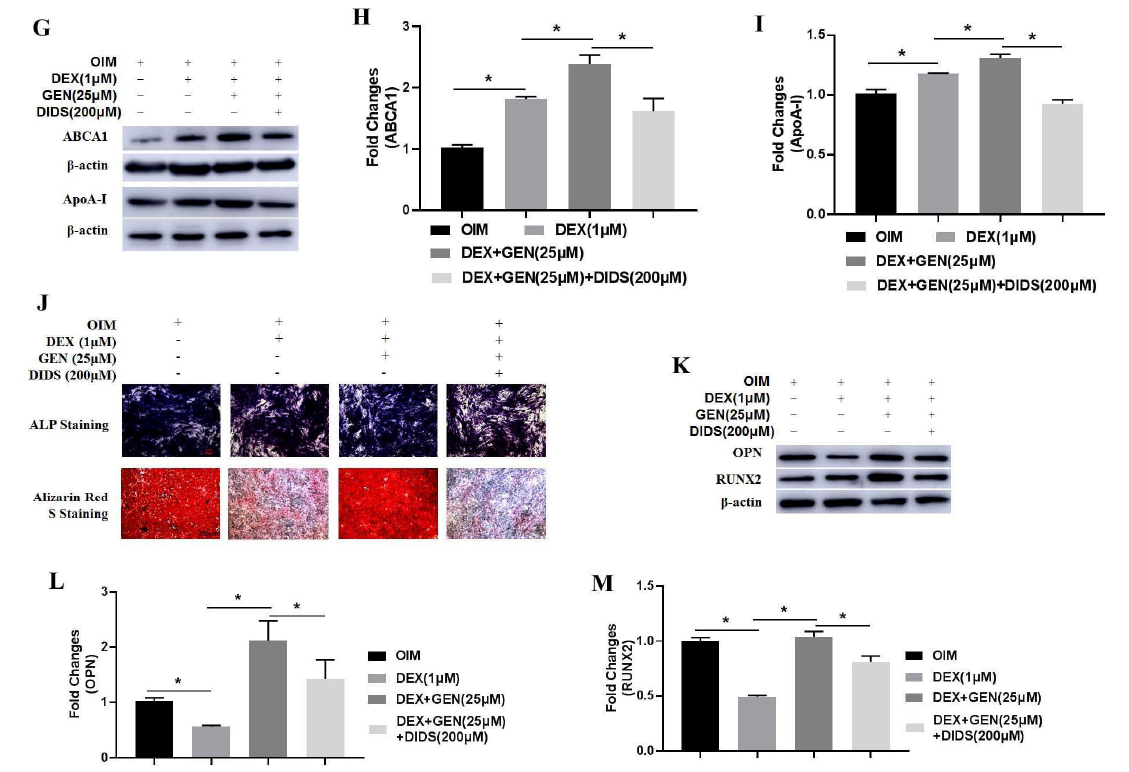
Figure 4. GEN ameliorated DEX-induced cholesterol accumulation by increasing ABCA1 expression. ( A , B ) The in vivo immunohistochemical examination of ABCA1 expression was conducted. ( C – E ) The protein expression of ABCA1 and ApoA-I was detected by western blot in DEX-treated MC3T3-E1 cells. ( F ) The level of the total intracellular cholesterol was measured using the ELISA kit in MC3T3-E1 cells co-treated with DEX and DIDS (200 µ M). ( G – I ) The protein expression of ABCA1 and ApoA-I was detected by western blot in DEX/DIDS-treated MC3T3-E1 cells. ( J ) The ALP staining and the Alizarin Red S staining assays were conducted ( × 100 magnification). ( K – M ) The protein expression of RUNX2 and OPN was detected by western blot in DEX/DIDS-treated MC3T3-E1 cells. All experiments were implemented separately in triplicate. * p < 0.05; ** p < 0.01. OIM, osteogenic induction medium. NC, negative control; 50 mg/kg, Dex + 50 mg/kg GEN; 100 mg/kg, Dex + 100 mg/kg